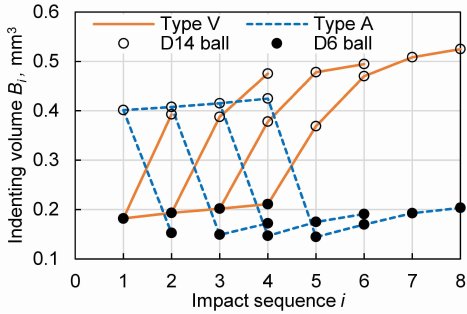
Figure 11. Raplaced volume by hammering